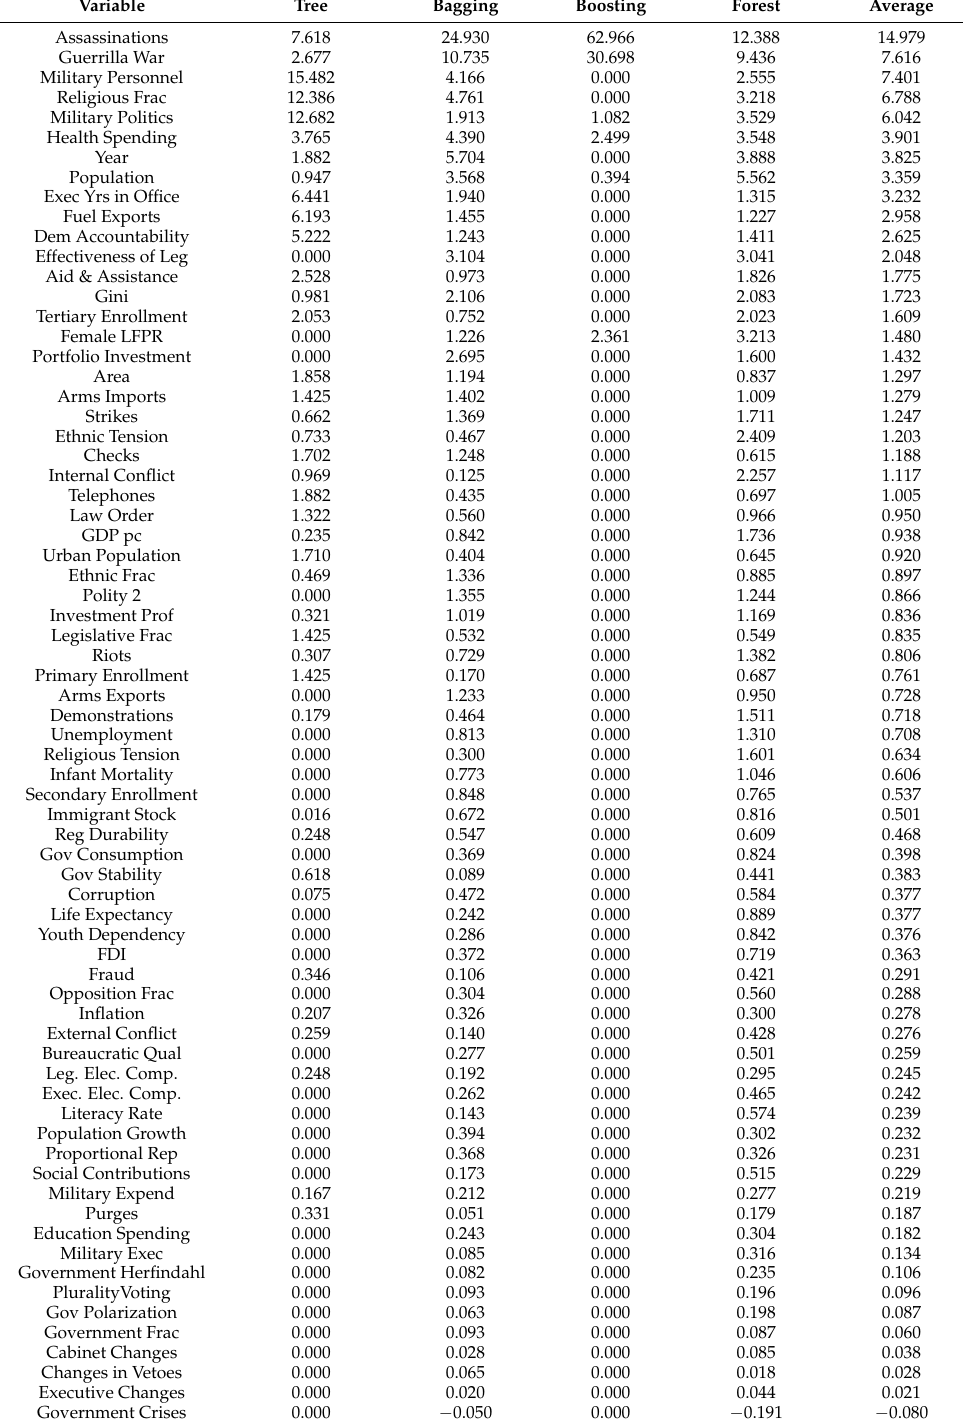
Table 3. Variable importance